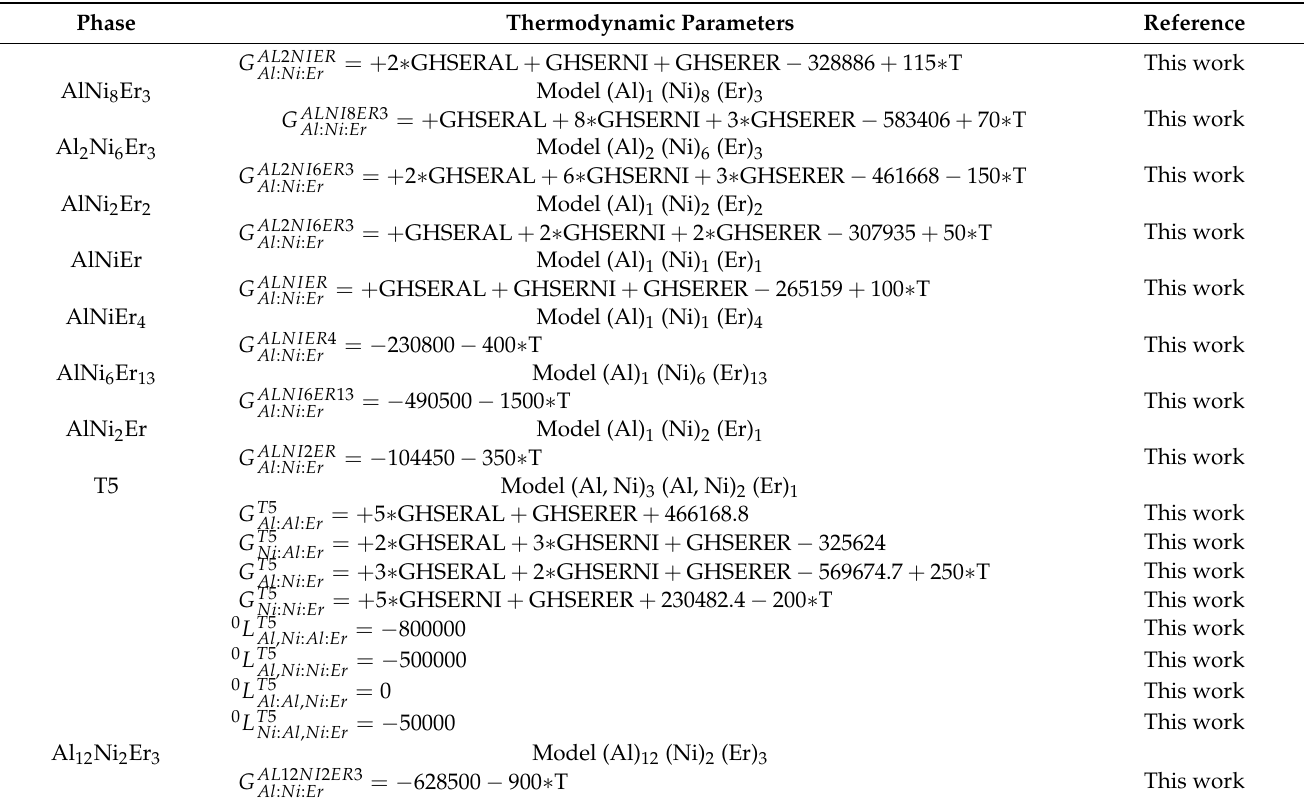
Figure 17. Calculated isothermal sections of the Al–Ni–Er ternary system at 700 °C compared with experimental data from this work and Zhao et al. [34] .